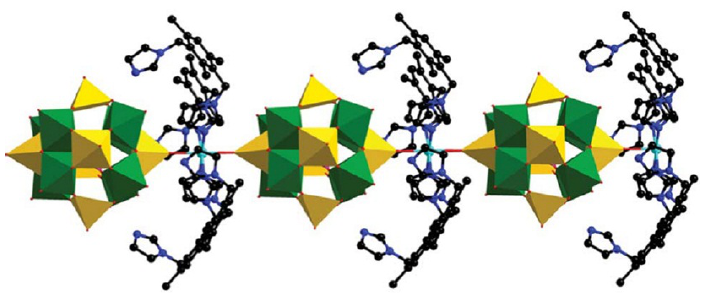
Figure 10. Polyhedral and ball-and-stick representation for the hybrid compound [Ni(m-bitmb) 4 ][H 5 PMo VI 8 V IV 4 O 40 (V IV O) 2 ]. Reproduced with permission from RSC, 2012 [51].